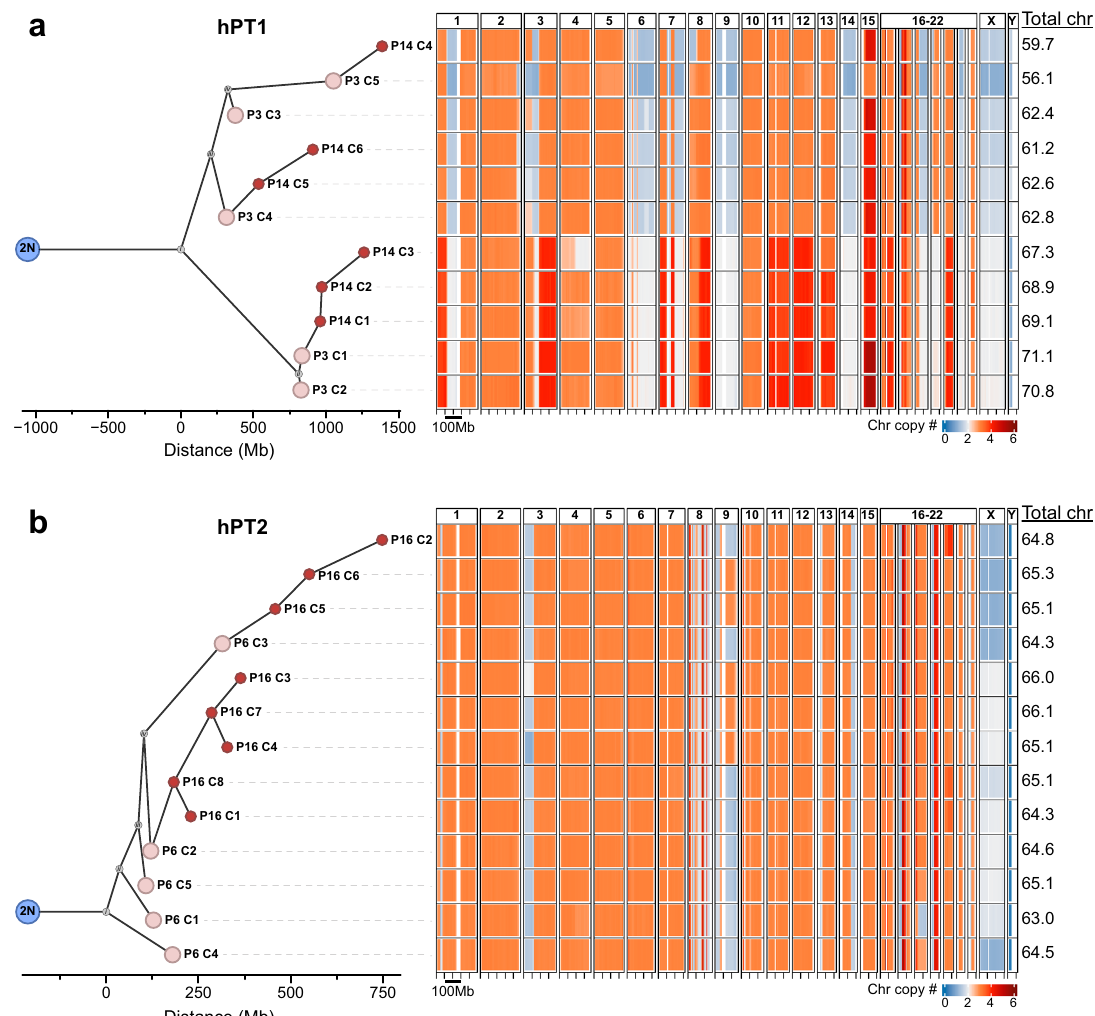
Fig. 3 Phylogenetic tree analysis reveals the correlation between the identi fi ed sub-population clusters and enables the quanti fi cation of genomic heterogeneity. The single-cell chromosome copy number data of the clusters identi fi ed in Fig. 2 were averaged and used to derive phylogenetic trees for hPT1 and hPT2. The maximum parsimony method was used to build the trees from the early passage clusters, followed by the minimal distance pairings of the late passage clusters. These trees reveal the correlation between the clusters of different culture periods and quantify the copy number differences between the clusters, as a measure of genomic heterogeneity. a hPT1 phylogenetic tree reveals two distinct groups of clusters that are separated by ~1500 Mb of copy number differences. Closer to the diploid (2 N) root, the fi rst group includes hPT1 P3 Clusters 3 – 5 (P3 C3 – 5), and hPT1 P14 Clusters 4 – 6 (P14 C4 – 6). P14 C5 – 6 are paired to P3 C4, while P14 C4 is paired to P3 C5. The estimated chromosome number ranges from 56.1 to 62.8. The other group of clusters, spread within ~500 Mb of copy number differences, includes P3 C1 – 2, and P14 C1 – 3, which are paired with P3 C1. The estimated chromosome number ranges from 67.3 to 71.1. b The clusters in the hPT2 phylogenetic tree are distributed within ~750 Mb of copy number differences, which is smaller than the hPT1 tree, suggesting lower genomic heterogeneity within the hPT2 population. The hPT2 P6 Clusters 1 – 5 (P6 C1 – 5) are spread within ~300 Mb and are closely related to each other. hPT2 P16 Clusters 1, 3, 4, 7, and 8 (P16 C1, C3 – 4, C7 – 8) are paired to P6 C2, while P16 C2 and C5 – 6 are paired to P6 C3. The estimated chromosome number ranges from 63 to differences between the clusters, as a measure of genomic within chromosome 9, which were caused by the clonal expansion heterogeneity. The hPT1 phylogenetic tree revealed two distinct in hPT2 P16 Clusters 3 – 7, and also other copy gains in groups of clusters that were separated by ~1500 Mb of copy chromosomes 3, 16, 18, and 20. All combined, the extended number differences (Fig. 3a). Closer to the diploid root, the fi rst culture resulted in approximately 25.7 Mb of copy gains and group includes hPT1 P3 Clusters 3 – 5 (P3 C3 – 5), and hPT1 P14 9.8 Mb of copy losses. Clusters 4 – 6 (P14 C4 – 6). P14 C5 – 6 are paired to P3 C4, while P14 Next, to investigate the evolutionary distance between the C4 is paired to P3 C5. These pairings indicate the correlation clusters of cells, the copy number pro fi les of each cluster were between the late passage clusters to the early ones, and again averaged and used to derive phylogenetic trees for hPT1 and con fi rm the existence of the same clonal population across the hPT2. The maximum parsimony method 29 was used to build the extended culture. The estimated chromosome number ranges trees from the early passage clusters, followed by the minimal from 56.1 to 62.8. The other group of clusters includes P3 C1 – 2, distance pairings of the late passage clusters. This approach and P14 C1 – 3, which are paired to P3 C1. The estimated enabled us to reveal the correlation between the clusters of cells chromosome number ranges from 67.3 to 71.1. Unlike the fi rst from different culture periods and to quantify the copy number